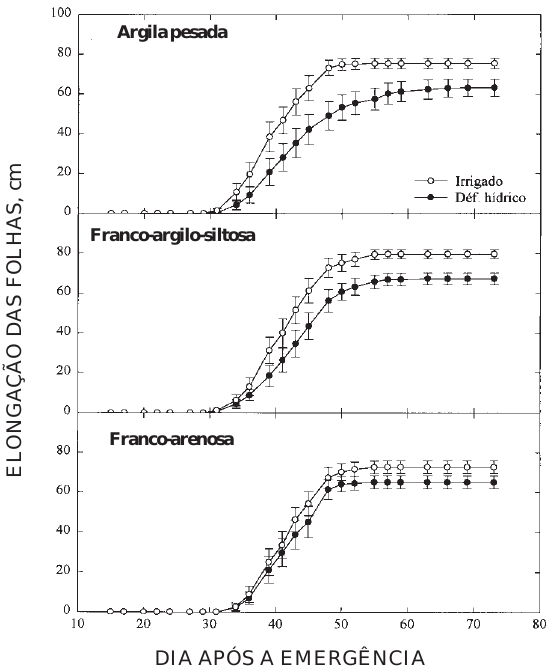
Figura 3. Expansão das folhas de plantas de milho submetidas a déficit hídrico e irrigadas em solos de diferentes texturas. As barras verticais representam o